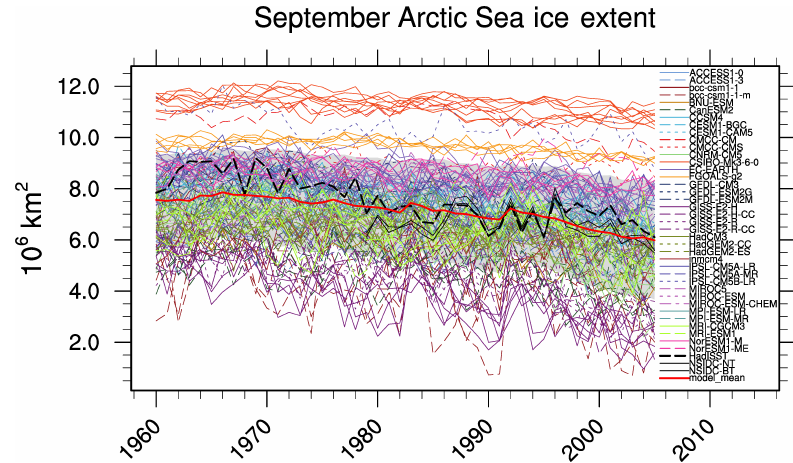
Figure 17. Time series (1960–2005) of September mean Arctic sea ice extent from the CMIP5 historical simulations. The CMIP5 ensemble mean is highlighted in dark red and the individual ensemble members of each model (coloured lines) are shown in different linestyles. The model results are compared to observations from the NSIDC (1978–2005, black solid line) and the Hadley Centre sea ice and sea surface temperature (HadISST, 1960–2005, black dashed line). Consistent with observations, most CMIP5 models show a downward trend in sea ice extent over the satellite era. The range in simulated sea ice is however quite large (between 3.2 and 12.1 × 10 6 km 2 at the beginning of the time series). The multi-model-mean lies below the observations throughout the entire time period, especially after 1978, when satellite observation became available. Similar to upper left panel of Fig. 9.24 of Flato et al. (2013) and produced with namelist_SeaIce.xml